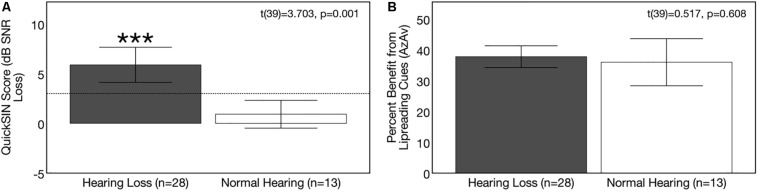
Baseline group differences in speech perception in noise. Average scores on speech perception measures in the age-related hearing loss group (n = 28) are depicted in gray and average scores for the normal hearing group (n = 13) are depicted in white. Black bars indicate 95% confidence intervals for each group. Asterisks indicate level of significance (***p ≤ 0.05). (A) Depicts average binaural auditory speech perception in noise scores (QuickSINTM). Scores are plotted in terms of the dB signal-to-noise ratio loss (dB SNR), representing the dB SNR required for the participant to score 50% of words in a sentence correct relative to normal hearing listeners. A higher score indicates poorer auditory speech perception in noise performance. The dotted line indicates the cutoff score (3 dB SNR) for normal function in background noise. The hearing loss group performed significantly poorer on the QuickSINTM test. (B) Depicts average benefit from visual (lipreading) cues on a binaural auditory-visual speech perception in noise test (AzAv). Scores indicate the percent difference score in an auditory-only condition relative to an auditory-visual condition, where a higher score indicates greater benefit from the addition of visual (lip-reading) cues. No significant difference was observed between groups in terms of lip-reading benefit.